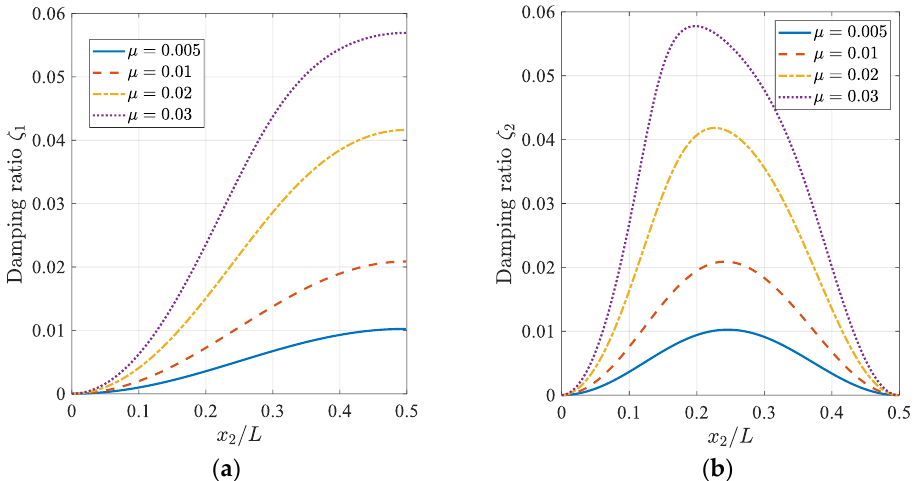
Figure 3. Modal damping of a cable with a single TM-HDR-D versus damper location 𝑥 2 /𝐿 ( 𝜑 = 0.5 ): ( a ) mode 1 ( 𝜌 = 1 ); ( b ) mode 2 ( 𝜌 = 0.5 ).